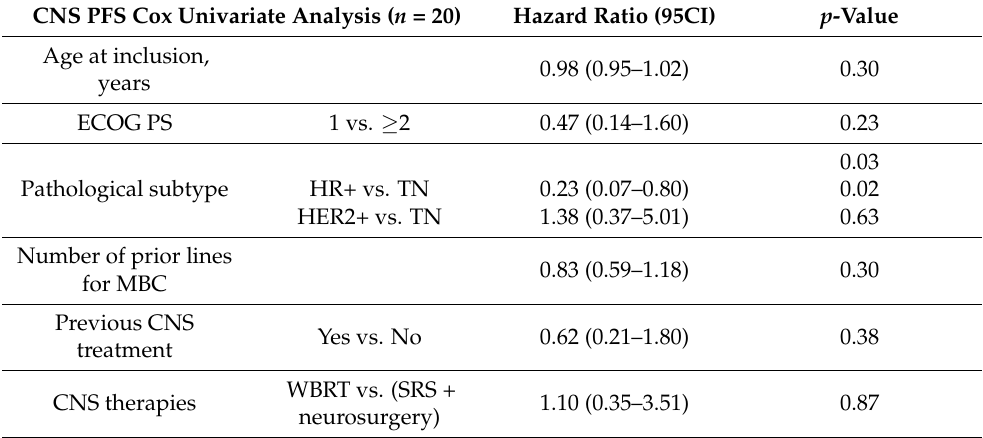
Table 2. Central nervous system (CNS) progression-free survival (PFS) cox regression univariate analysis.